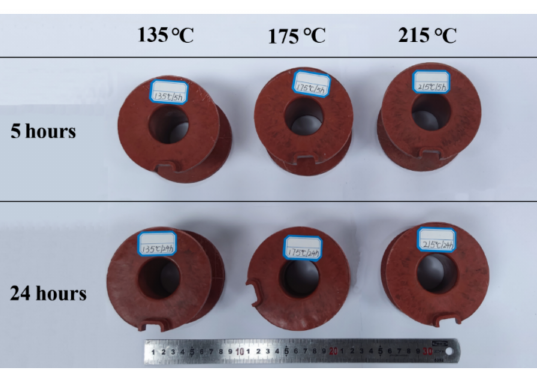
Figure 4. Silicone resin coil bobbins after oven